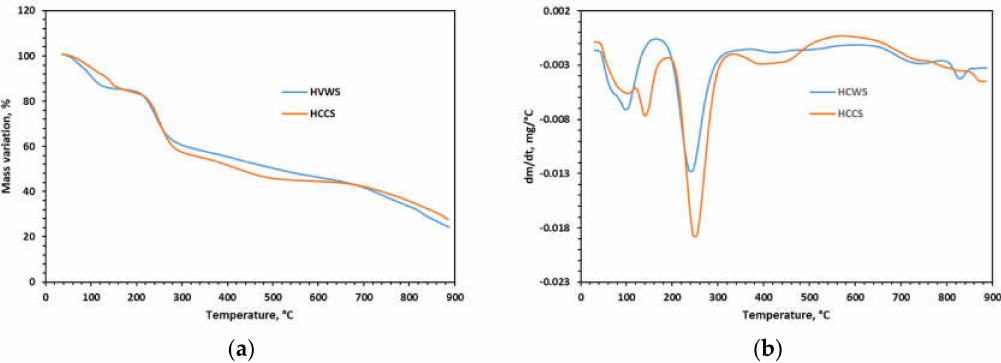
Figure 7. ( a ) Mass variation curves; ( b ) DTG curves, for the separated hemicellulose samples.